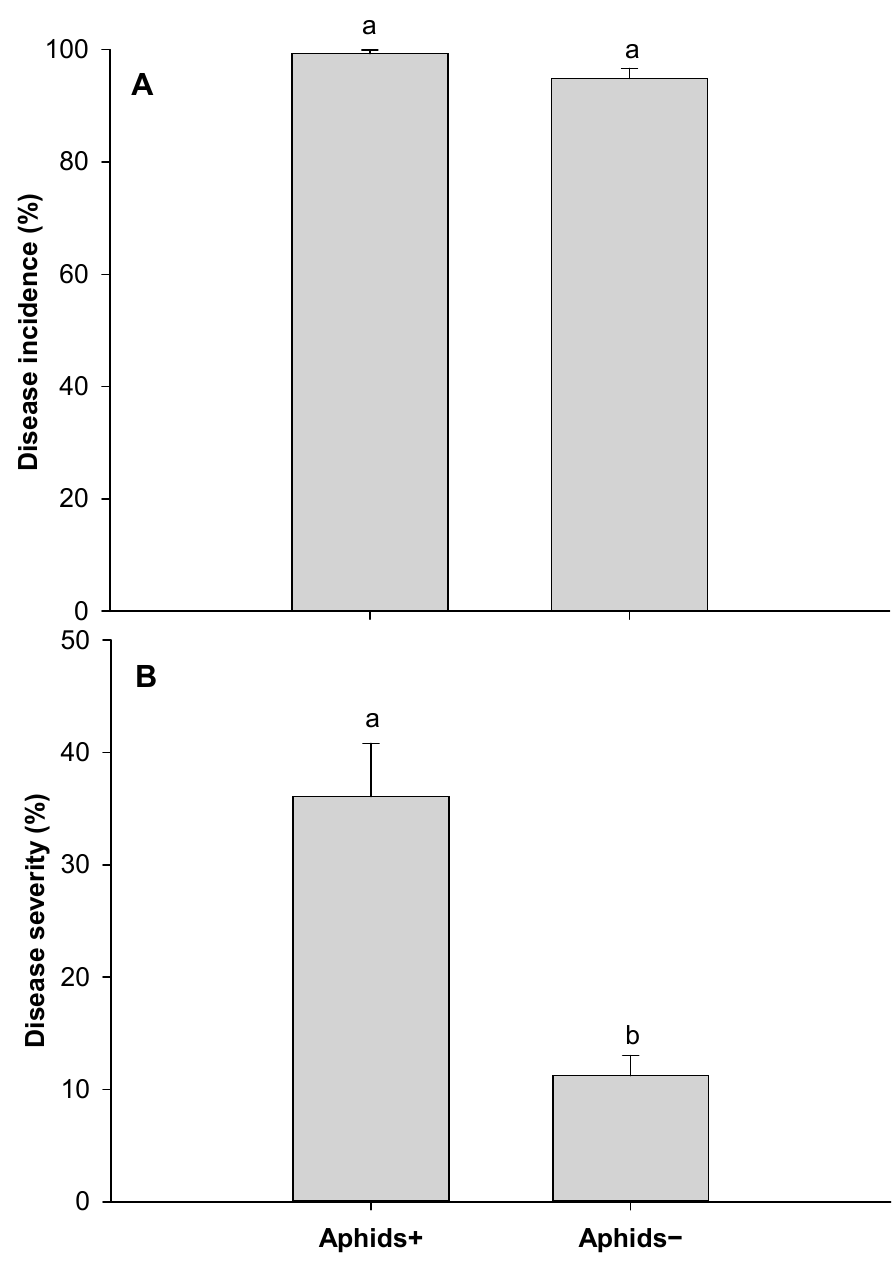
Figure 3. Stagonospora nodorum blotch 11 days after inoculation: Disease incidence ( A ) and disease severity ( B ) on aphid ( Rhopalosiphum padi ) infested (Aphids+) and non-infested (Aphids − ) wheat plants from experiment 2. Error bars are standard error of the mean values and bars with different letters are different according Tukey’s test at p = 0.05.